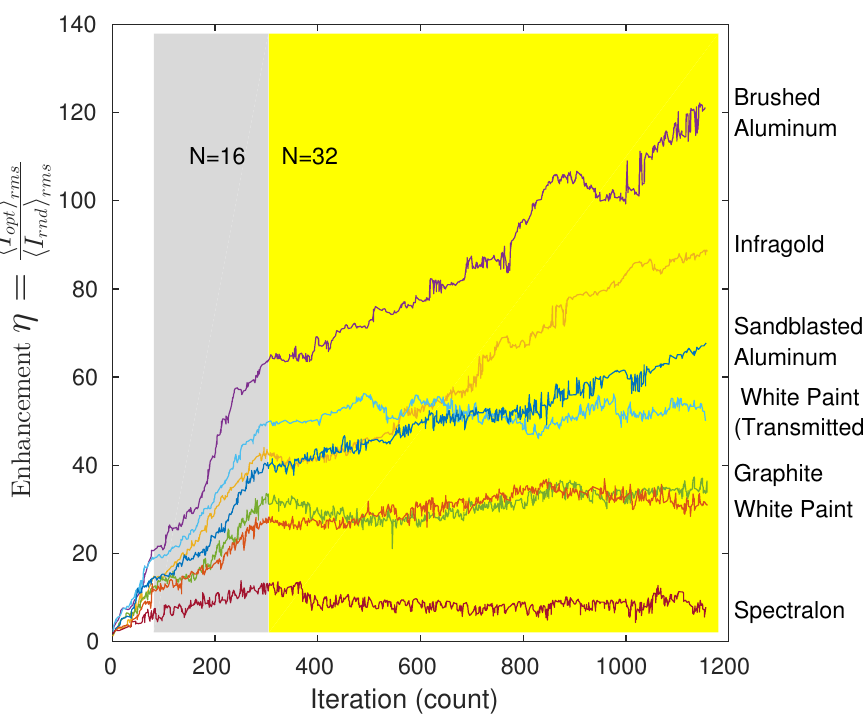
Figure 2. Simulation validation. The diffusely-reflecting sample was replaced by a mirror to compare measured and simulated intensity patterns. A negative lens phase screen was used to position the focus onto the